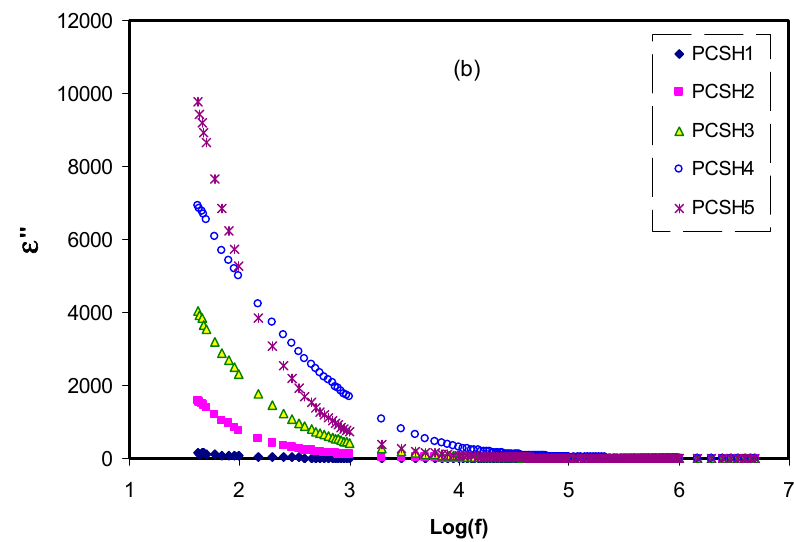
Figure 4. Variation of ( a ) dielectric constant ( ε′ ) and ( b ) dielectric loss ( ε″ ) with frequency for the polymer blend electrolyte samples.